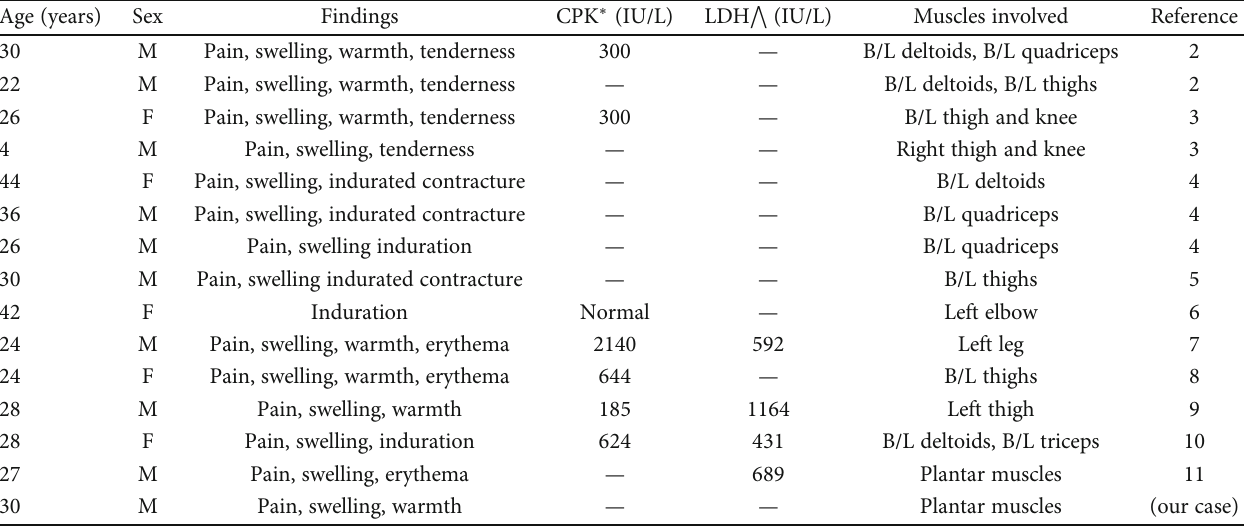
Table 1: Reported cases of myonecrosis in sickle cell